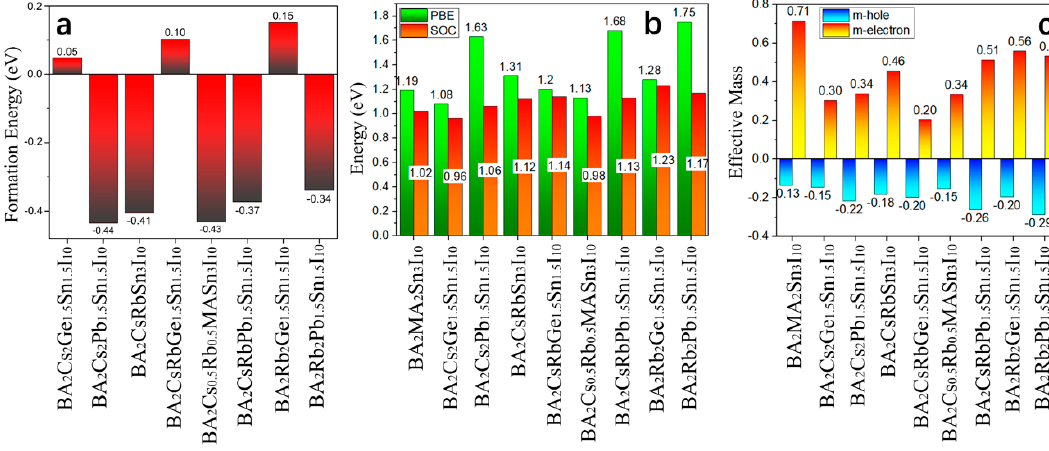
Figure 6. ( a ) Formation energies of the 2D SnI-based systems with various mixed atoms (Cs, Rb, Ge, and Pb). ( b ) Bandgaps of the 2D SnI-based systems with various mixed atoms (Cs, Rb, Ge, and Pb). ( c ) Carrier effective masses for the 2D SnI-based systems with various mixed atoms (Cs, Rb, Ge, and Pb).